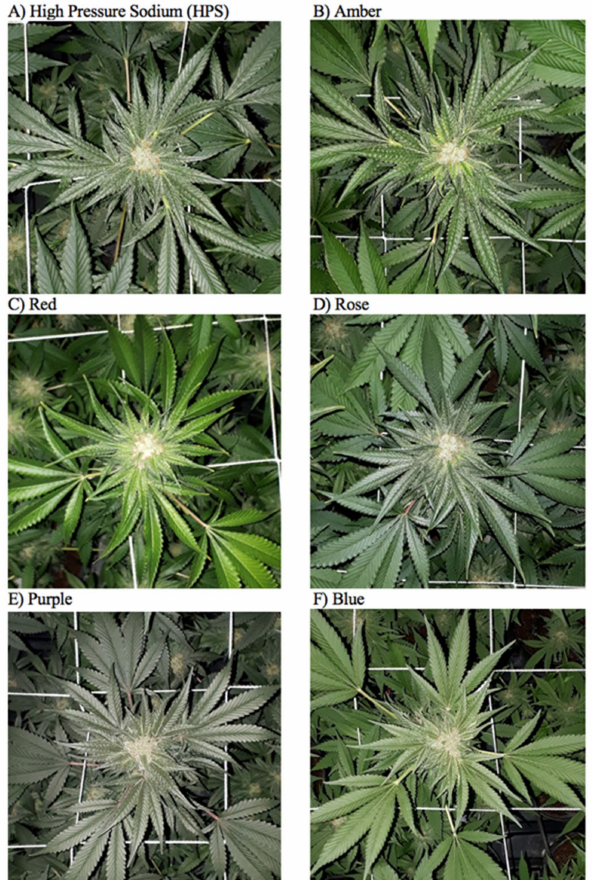
Figure 3. Representative images of leaf and inflorescence coloration under each light treatment one week before harvest. Treatments are ( A ) high-pressure sodium (HPS), ( B ) amber (595 nm), ( C ) red (630 nm), ( D ) rose (430 + 630 nm, B:R ratio 1:10), ( E ) purple (430 + 630 nm, B:R ratio 2:1), and ( F ) blue (430